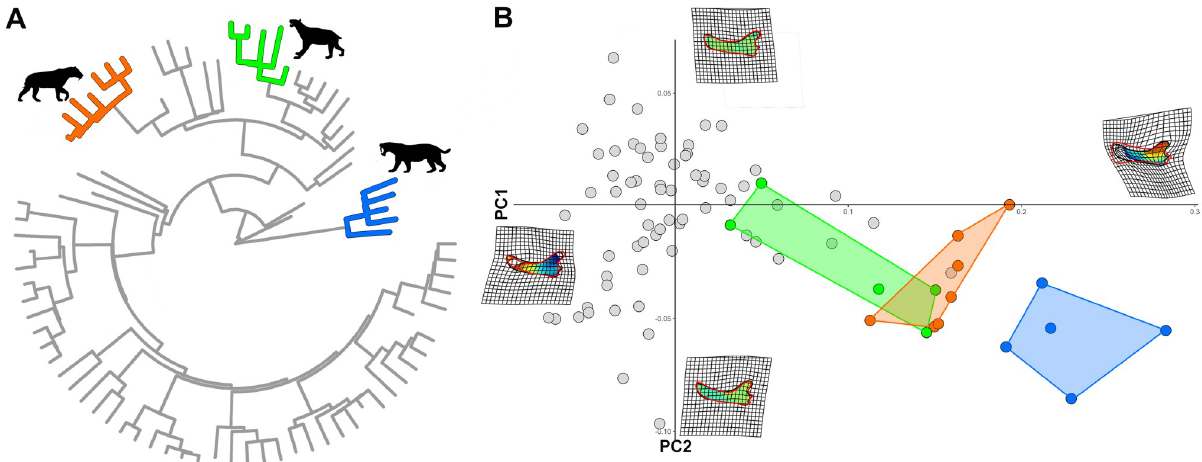
Fig 5. Convergence among mandibular shapes in felids. A) The clades found to converge were Homotheriini (orange) and Barbourofelidae (blue) and Smilodontini (green). B) PC1/PC2 plot showing the position of the convergent clades compared to the rest of the tree. Deformation grids are shown at the extremes of both axes. The silhouette for Homotherium was available for reuse under the Creative Commons Attribution 3.0 Unported (https://creativecommons.org/licenses/by-sa/3.0/) at http://phylopic.org/image/c6c2d17b-56b3-4c87-97c4-cd2b7de365fa/ (image by Zimices). The silhouettes for Smilodon and Barbourofelis are our own